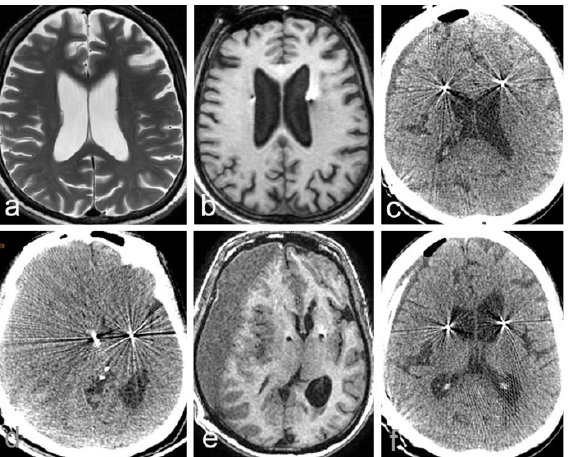
Figure 1. The change in MRI and CT images of the patient 1. ( a ) Conventional brain MRI, T2 image showed mild atrophy and dilation of the ventricles; ( b ) The image of the intraoperative 3 dimensional T1-weighted sequence showed no subdural effusion in bilateral frontal areas; ( c ) At 5 day after DBS surgery, CT shows a small amount of subdural effusion and pneumocephalus in the right frontal lobe; ( d , e ) At 36 days after DBS surgery, CT and T1 MRI images of the brain shows right chronic subdural hematoma, with the midline obviously shifted to the left, and a marked shift in electrode positioning; ( f ) At 2 days after drainage, CT shows that most of the hematomas were drained out and the electrode shift has been corrected.